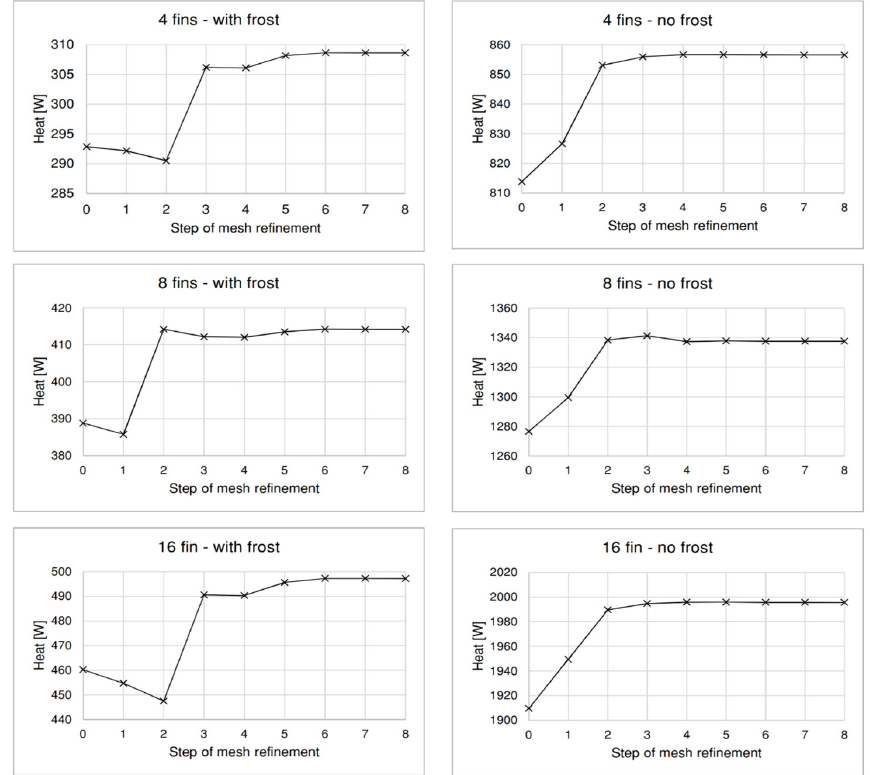
Figure 7. Total heat depending on the mesh refinement.